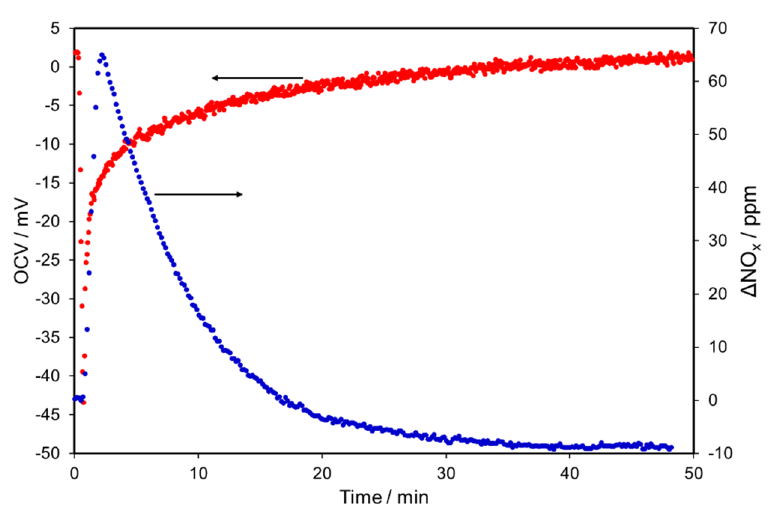
Figure 7. Variations of OCV and Δ NO x as a function of time at 500 °C. Reactive mixture: NO/NO 2 /O 2 : 650 ppm/40 ppm/1% in He.